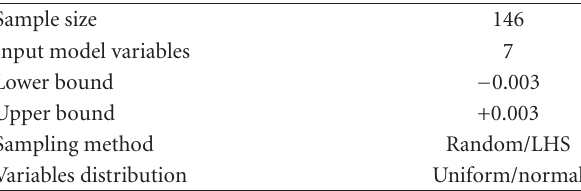
Table 1: Input file information